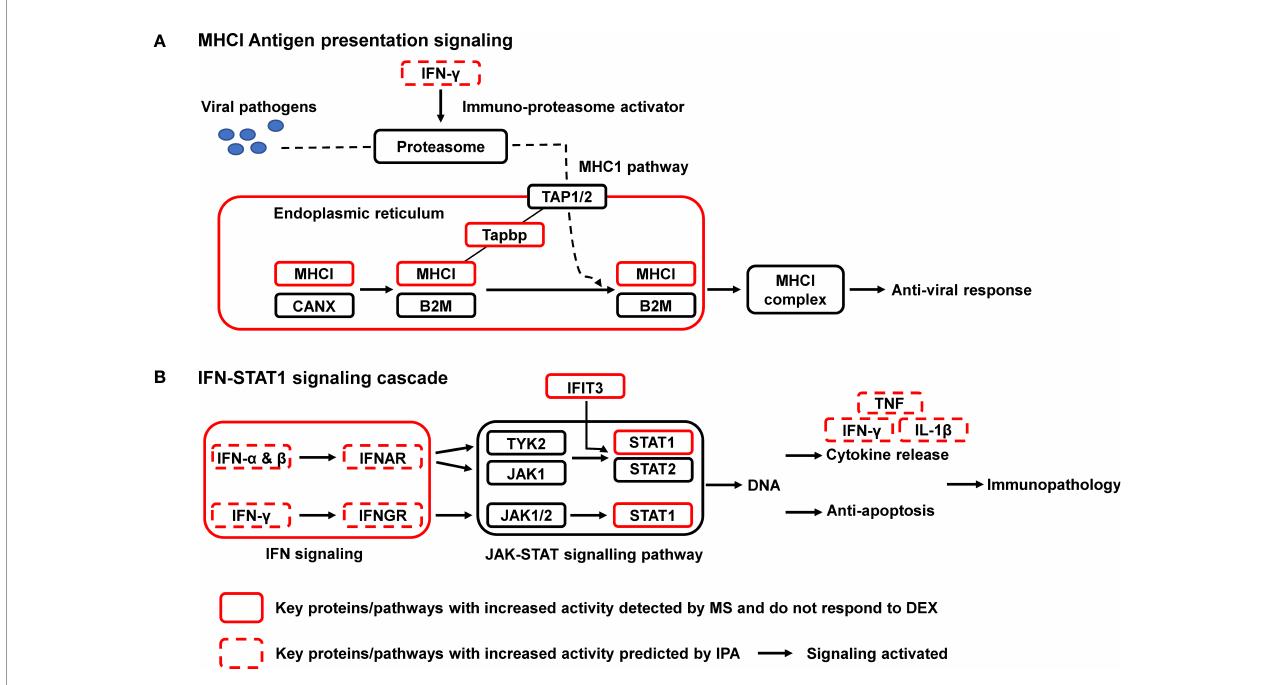
FIGURE 3 | Signaling pathway enrichment in a mouse steroid-resistant asthma exacerbation model. The reconstruction of protein networks was based on Ingenuity Pathway Analysis (IPA) and literature searching. The most regulated signal transduction pathways and the major changes in protein components of these pathways are displayed. (A) MHCI Antigen presentation signaling; (B) IFN-STAT1 signaling cascade. MHC I, class I major histocompatibility complex; B2M, b 2 macroglobulin; CANX, chaperone calnexin; TAP, transporters associated with antigen processing; Tapbp, tapasin, TAP binding protein; IFN, interferon; JAK, Janus tyrosine kinase; STAT, signal transducer and activator of transcription; IFNAR/IFNGR, interferon receptor. IFIT3, interferon induced protein with tetratricopeptide repeats 3; TNF, tumor necrosis